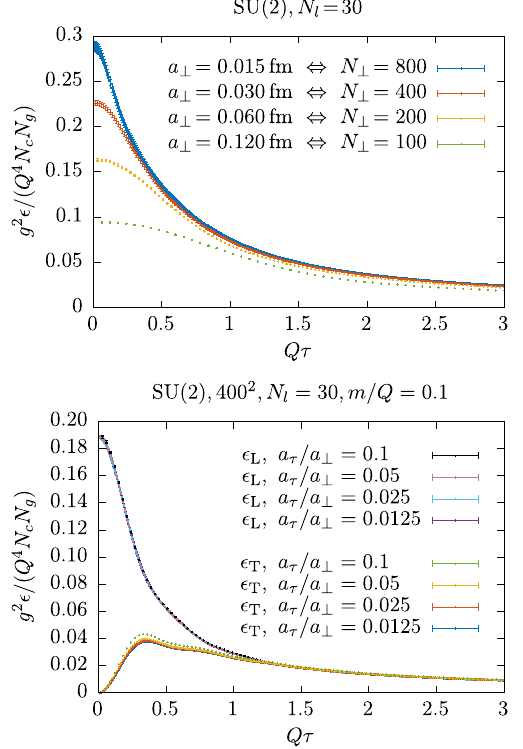
Fig. 3 Total energy density for different transverse lattice spacings a ⊥ (top) and different temporal lattice spacings a τ (bottom)